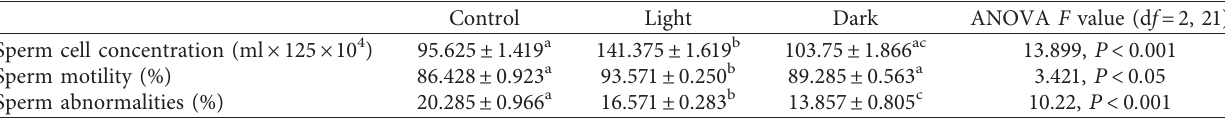
Table 2: Sperm parameters following exposure to prolonged light or prolonged